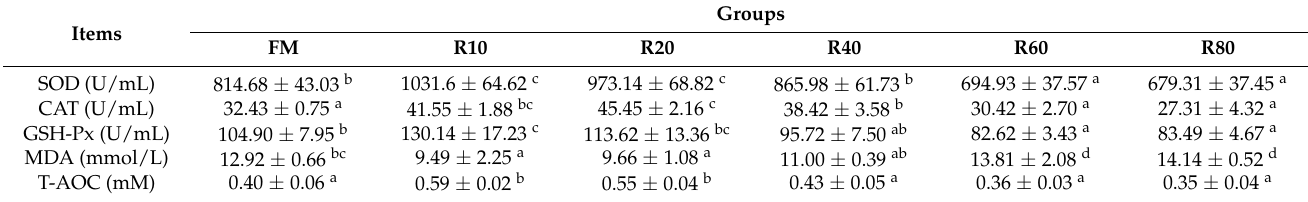
Table 6. Effects of RPM replacing fishmeal on serum antioxidant indexes for L. vannamei .